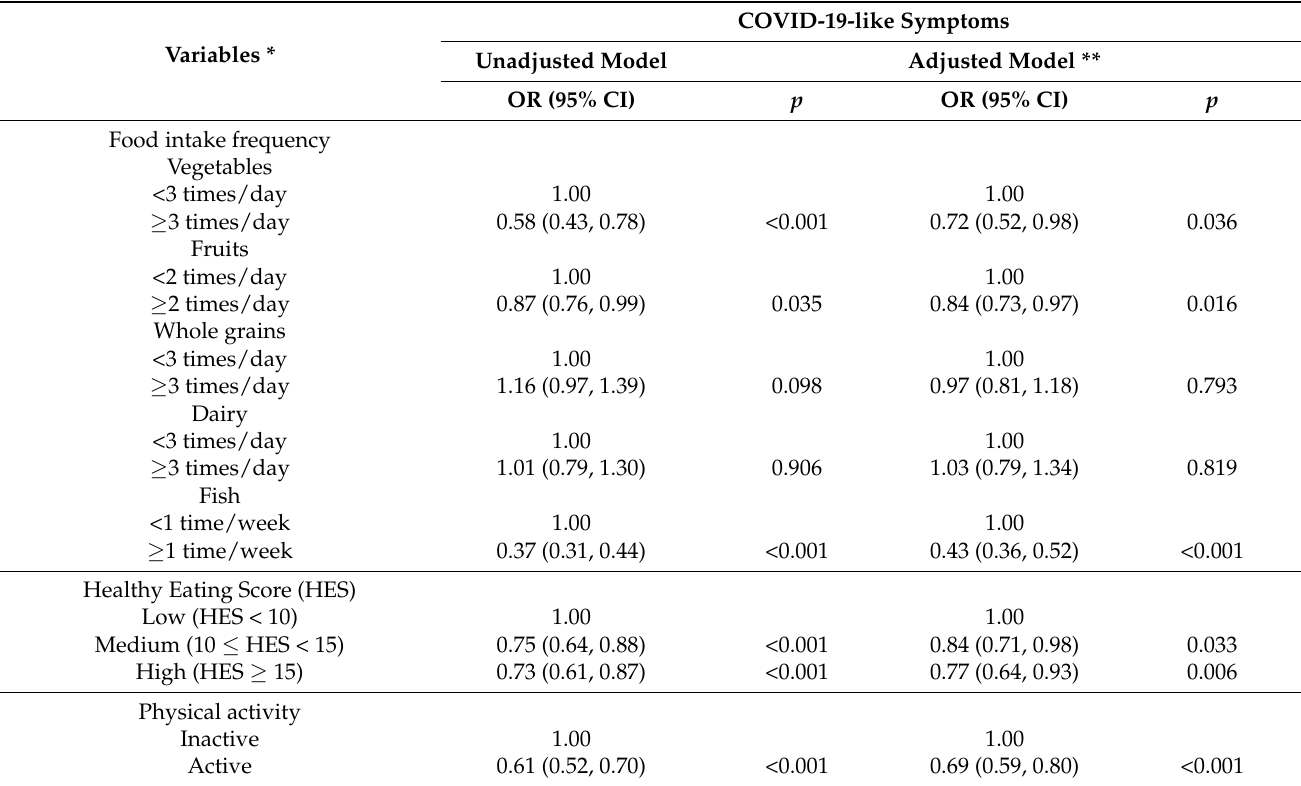
COVID-19-like Symptoms